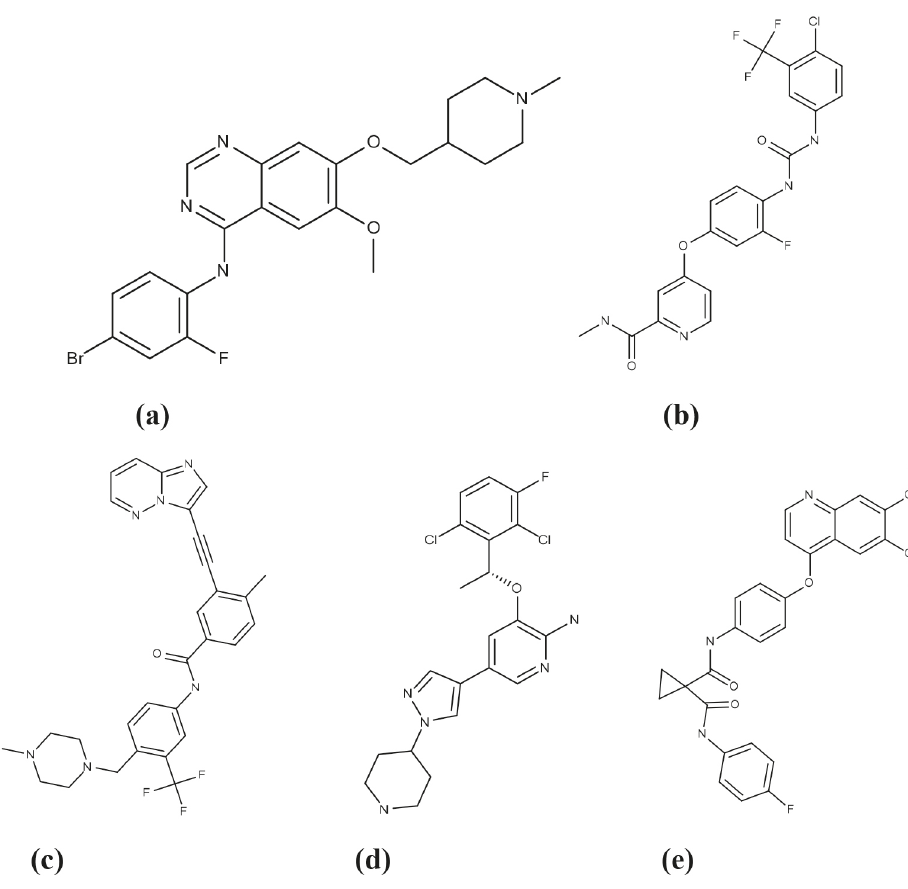
FIGURE 1 - Vandetanib (a), Regorafenib (b), Ponatinib (c), Crizotinib (d) Cabozantinib (e).